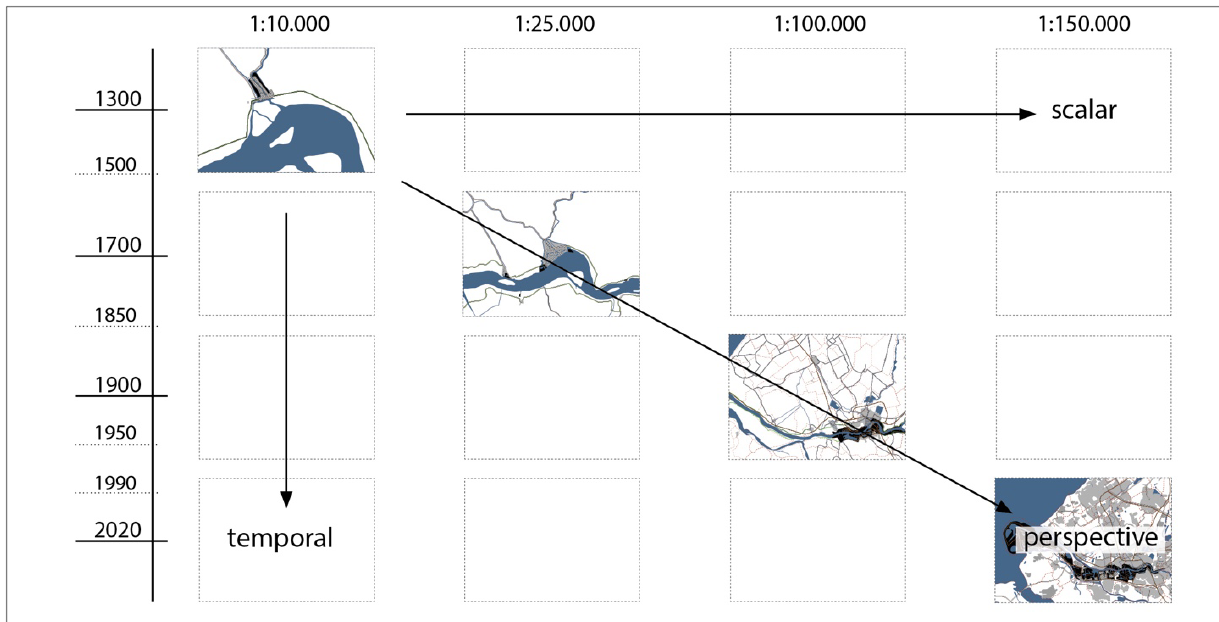
Figure 6. Conceptualization of different approaches to historical geo-spatial mapping and their usefulness for particular disciplinary approaches or questions. Figure by Carola Hein, Yvonne van Mil, Blanka Borbely, and Batuhan Özaltu based on Global Administrative Boundaries (2018) CORINE Land Cover (2016) and EuroGlobalMap